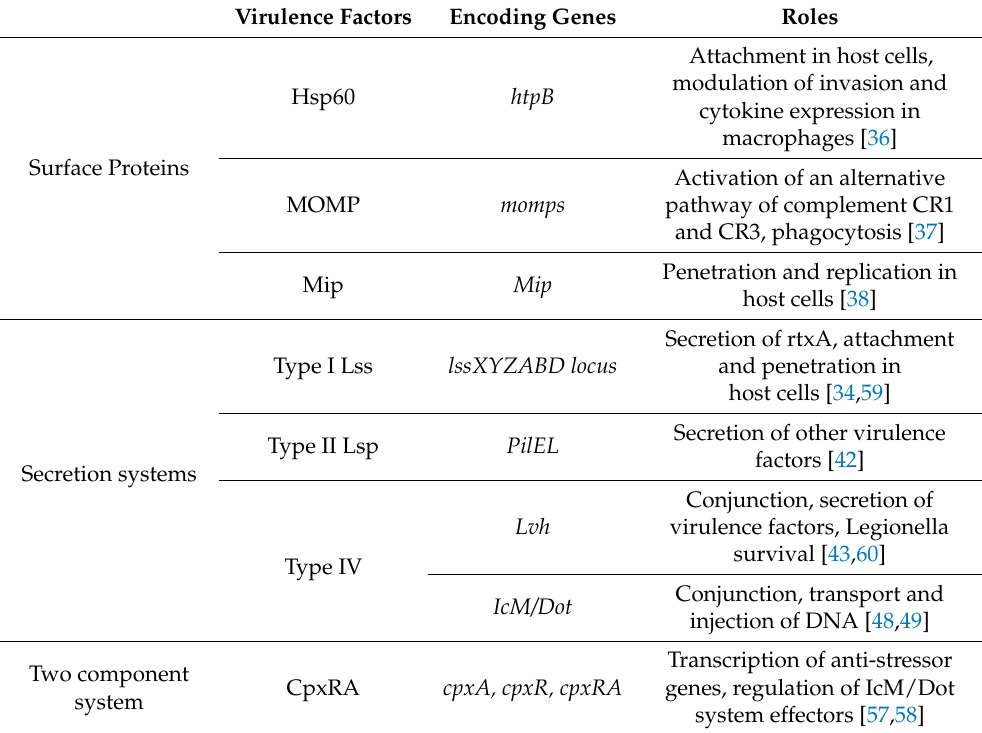
Table 1. L. pneumophila virulence